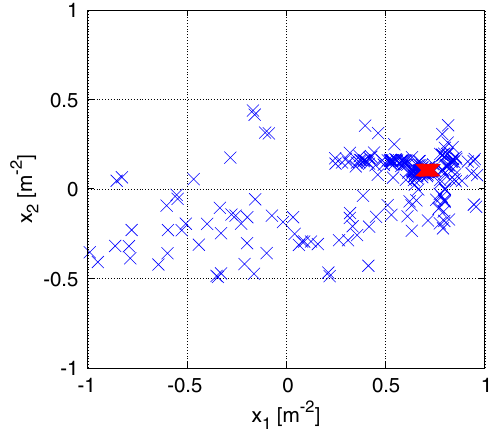
FIG. 13. Spread of all the individuals in the simulation in the ; x Þ subdimension of the entire search space (blue points), ð x 1 2 and those with the value of the objective functions below 10 (cid:1) 10 (red). The simulation shows 25 generations with 24 individuals apiece.